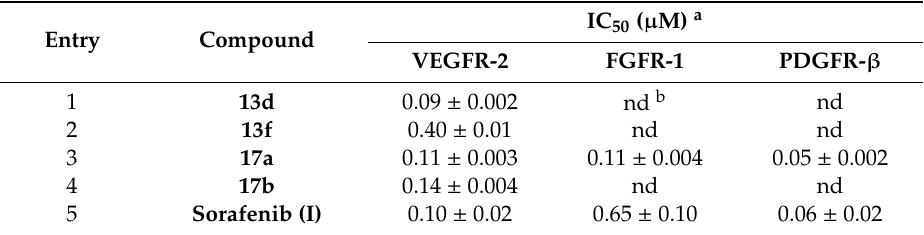
Table 5. Biochemical kinase inhibitory activity of selected benzimidazoles on VEGFR-2, FGFR-1 and PDGFR- β .